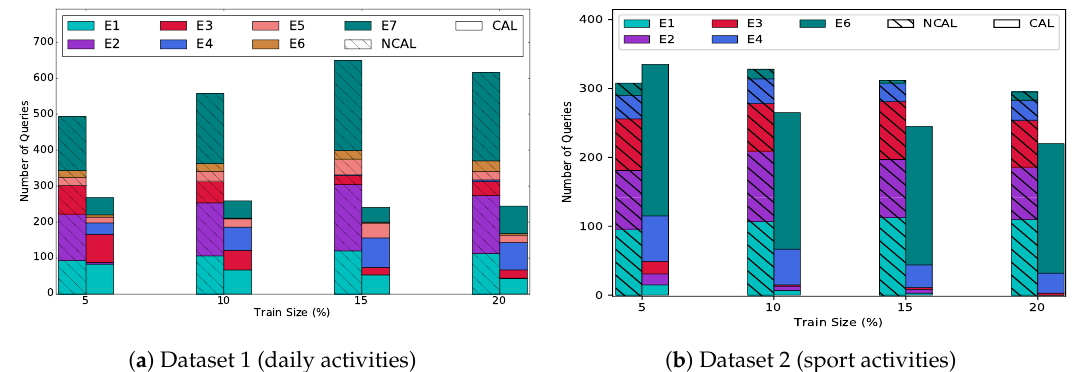
Figure 10. Comparison of non-collaborative and collaborative active learning in terms of total number queries. Each color corresponds to a different expert. The number of queries from imperfect (E2, E3) and perfect (E1) experts decreases in the collaborative learning because on-demand experts (( a ) E4-E7, ( b ) E4 & E6) increase their knowledge in the previous